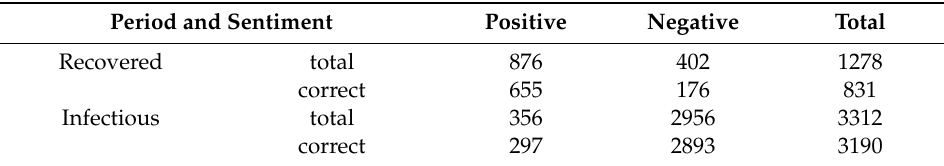
Table 4. LSTM Test Set Result.